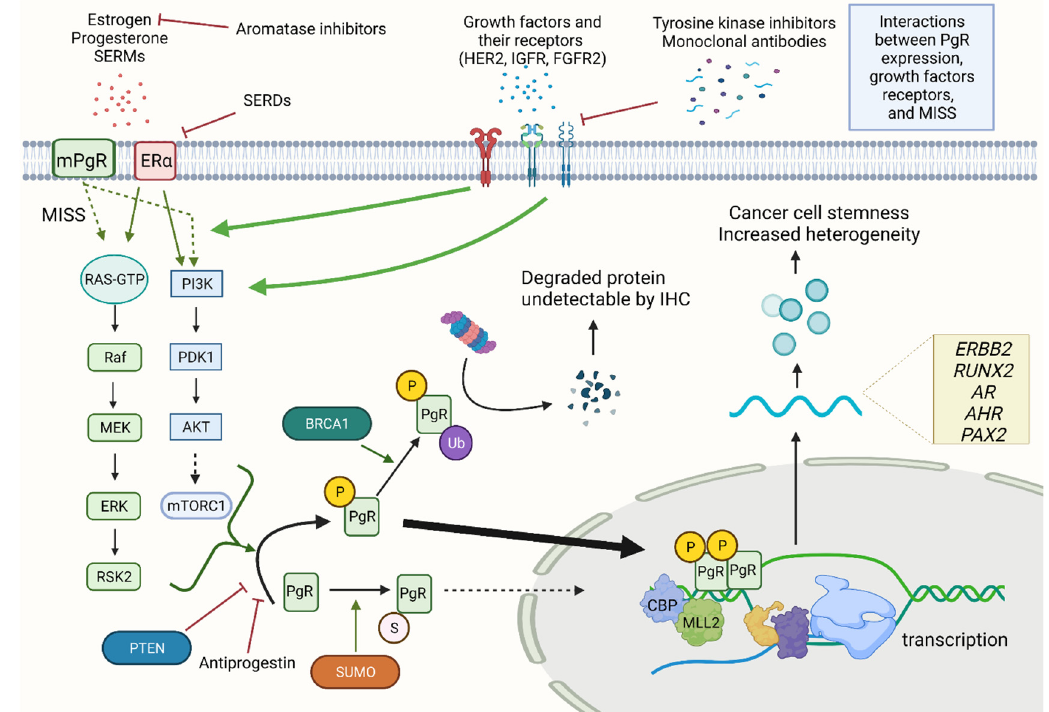
Figure 1. Interactions between PgR, growth factor-dependent signaling and MISS Green arrows demonstrate stimulatory effects, red T-shaped lines depict inhibition. Overactive growth factors receptors stimulate MISS and directly activate various signaling pathways leading to activation of multiple kinases, i.e., ERK, AKT, RSK2, mTORC1, which phosphorylate PgR at Ser294. Phosphorylated PgR is undersumoylated, undergoes rapid ubiquitination and degradation in proteasomes reflected by PgR( − ) status in immunohistochemistry. Phosphorylated PgR is also transcriptionally overactive, recruits CBP and MLL2, and enhances transcription of genes involved in cancer progression. Abbreviations: AHR —aryl hydrocarbon receptor; AKT—protein kinase B; AR —androgen receptor; BRCA1—Breast cancer type 1 susceptibility protein; CBP—CREB-binding protein; ER α —estrogen receptor α ; ERBB2 —Erb-B2 Receptor Tyrosine Kinase 2; ERK—extracellular-regulated kinase; FGFR2—fibroblast growth factor receptor 2; HER2—human epidermal growth factor receptor 2; IGFR—insulin-like growth factor receptor; IHC—immunohistochemistry; MEK—mitogen-activated protein kinase; MISS—membrane-initiated steroid signaling; MLL2—mixed linage leukemia gene 2; mTORC1—mammalian target of rapamycin complex 1; P—phosphate residues; (m)PgR—(membranous) progesterone receptor; PAX2 —paired box 2; Raf—rapidly accelerated fibrosarcoma; PDK1—3-phosphoinositide-dependent protein kinase-1; PI3K—phosphoinositide 3-kinase; PTEN—phosphatase and tensin homolog; RAS—rat sarcoma virus; RSK2—ribosomal S6 kinase 2; RUNX2 —RUNX Family Transcription Factor 2; SERDs—selective estrogen receptor degraders; SERMs—selective estrogen receptor modulators; Ub—ubiquitin.